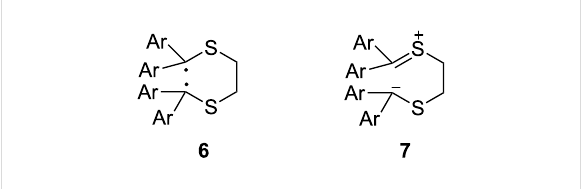
Figure 1: Structures of the reactive intermediates as a diradical 6 or a zwitterion 7 in the course of the dimerization of a reactive diaryl thio- carbonyl S